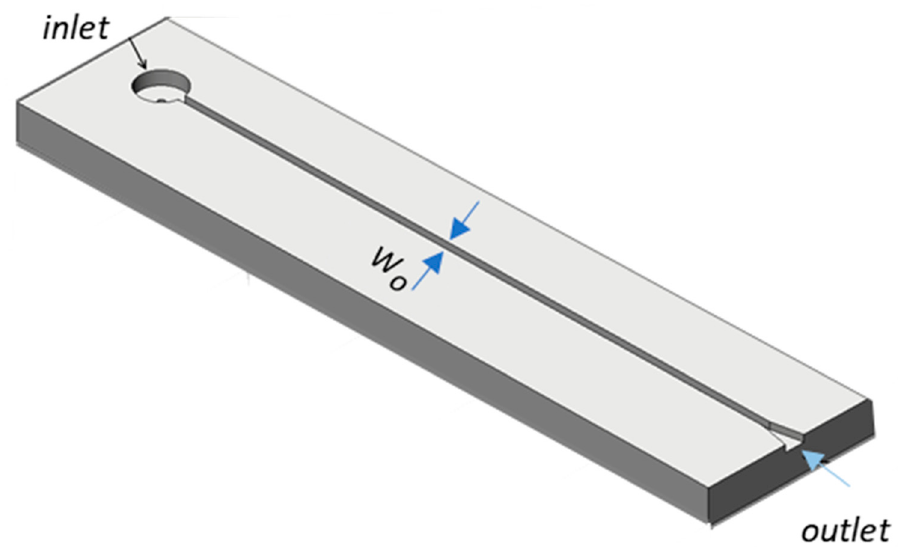
Figure 1. The experimental setup.